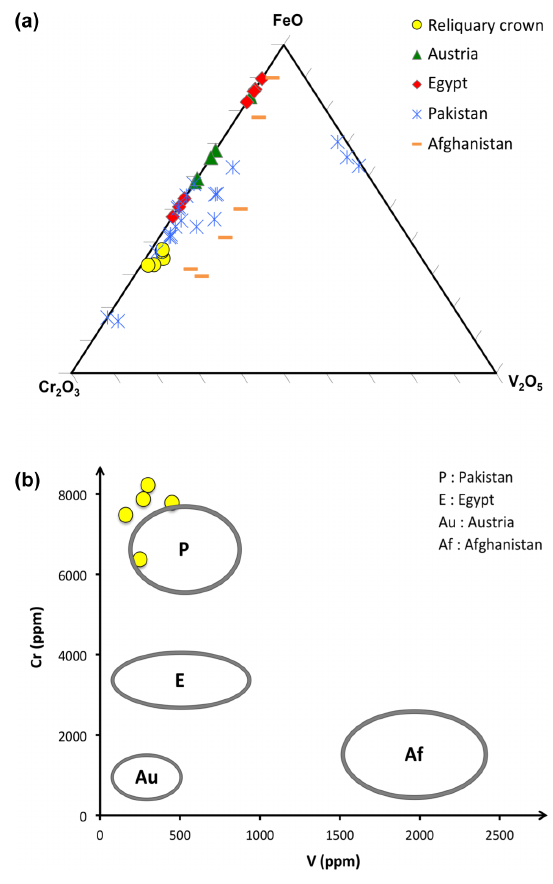
Figure 4. Chemical compositions of emerald from the reliquary crown of Namur compared to those of emerald from various lo- calities. The ternary Cr 2 O 3 –V 2 O 5 –FeO diagram (a) , as well as the chromium-vanadium diagram (b) , were established by Groat et al. (2008) and Aurisicchio et al.